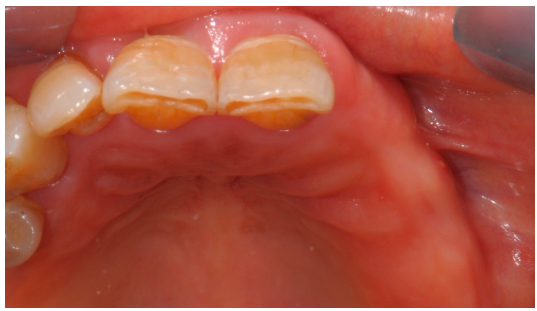
Figure 9. Three-month follow-up after surgical treatment for MRONJ: complete clinical healing was achieved both in mandible and maxilla.